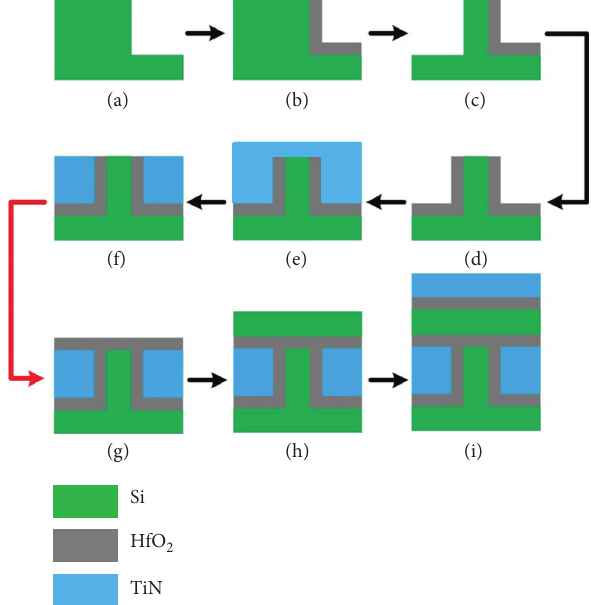
Figure 2: The fabrication flow of the PSF-TiFET device. (a) For- mation of a right sidewall of the Si-fin channels, (b) the formation of high-K dielectric layer on the right sidewall, (c) formation of another left sidewall of the Si-fin channels, (d) formation of the gate oxide of the front gate on the left sidewall, (e) TiN deposition, (f) gate separation by RIE, (g) formation of the oxide layer on the top gate, (h) formation of a horizontal channel by using smart-cut processing, and (i) formation of the high-K dielectric layer and the top